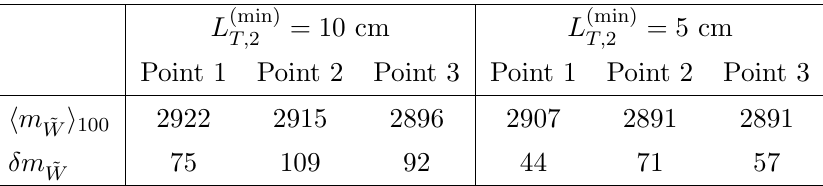
Table 2 . The mean of the peak position based on 100 data sets of pp ! ~ g ~ g events for each Sample Point, denoted as h m ~ i 100 , as well as the uncertainty in the Wino mass determination (in units of W